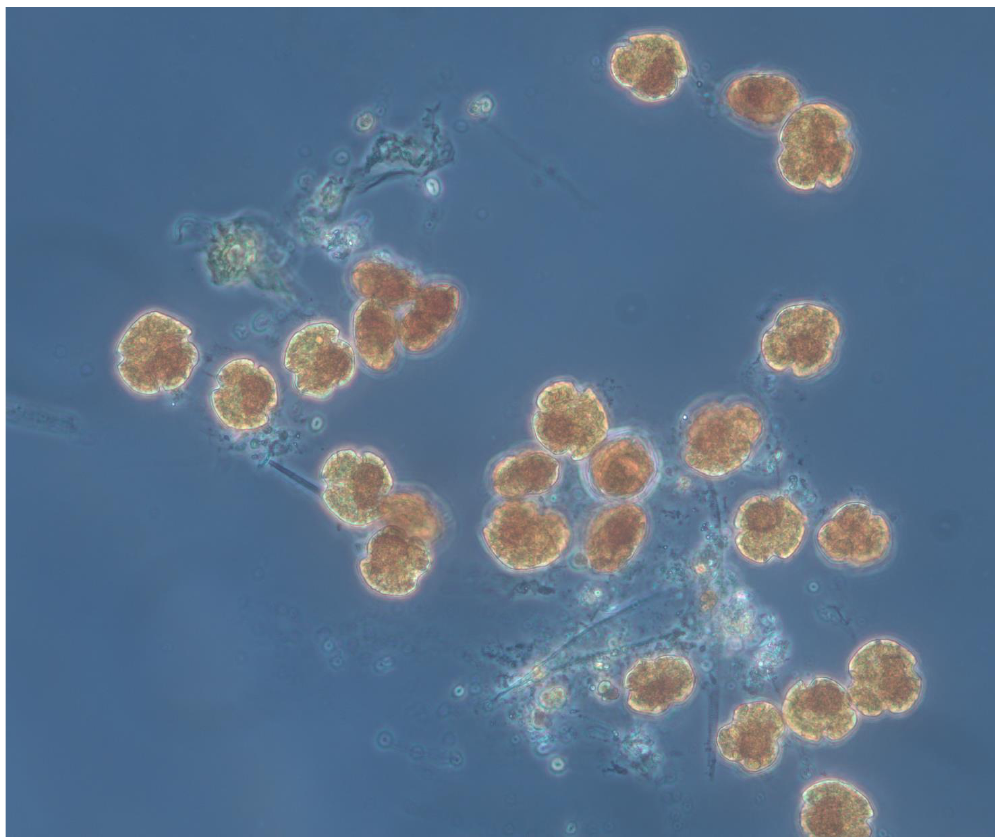
Figure 8. Light micrograph (phase-contrast) of cells of Karenia mikimotoi . Notice the clover leaf